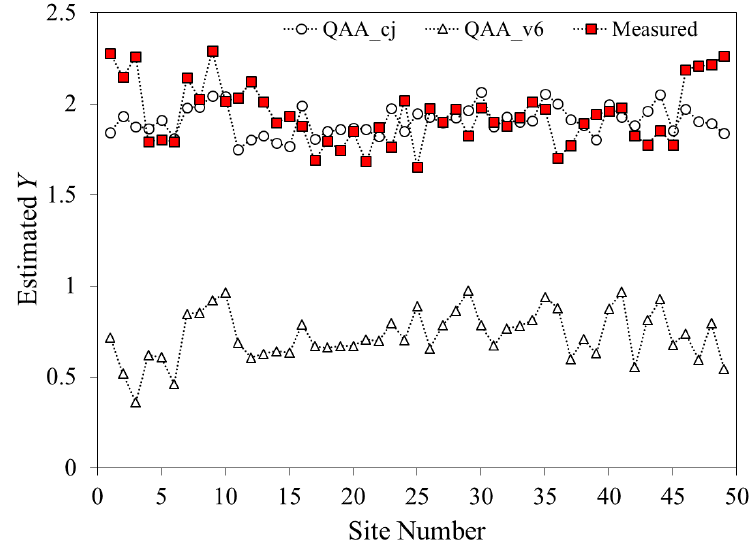
Figure 6. Comparison of in situ and predicted Y values. The filled squares are in situ Y values, empty circles and triangles denote Y values derived from QAA_cj and QAA_v6, respectively.